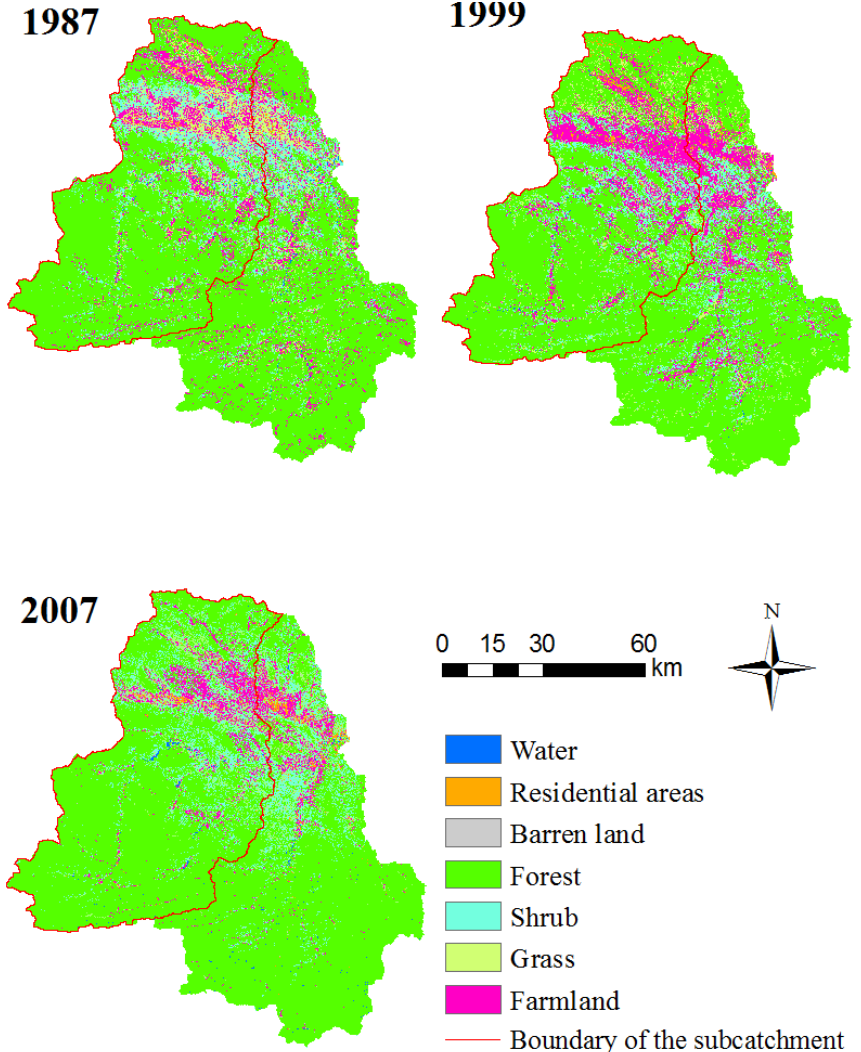
Figure 2. Land use changes during the three